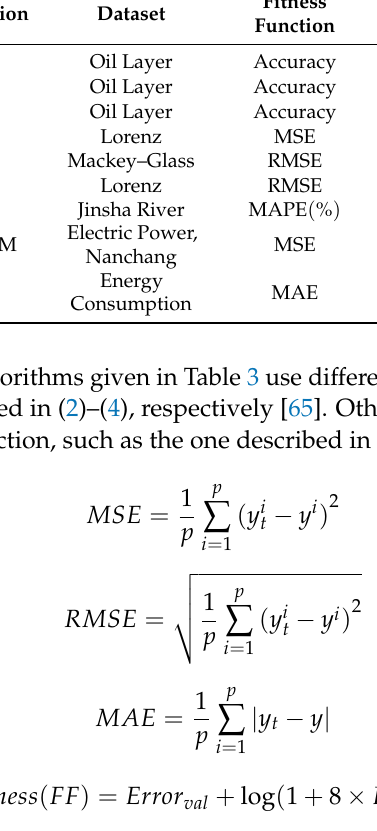
Table 3. Optimization algorithms applied to ML methods for the prediction of chaotic time series.